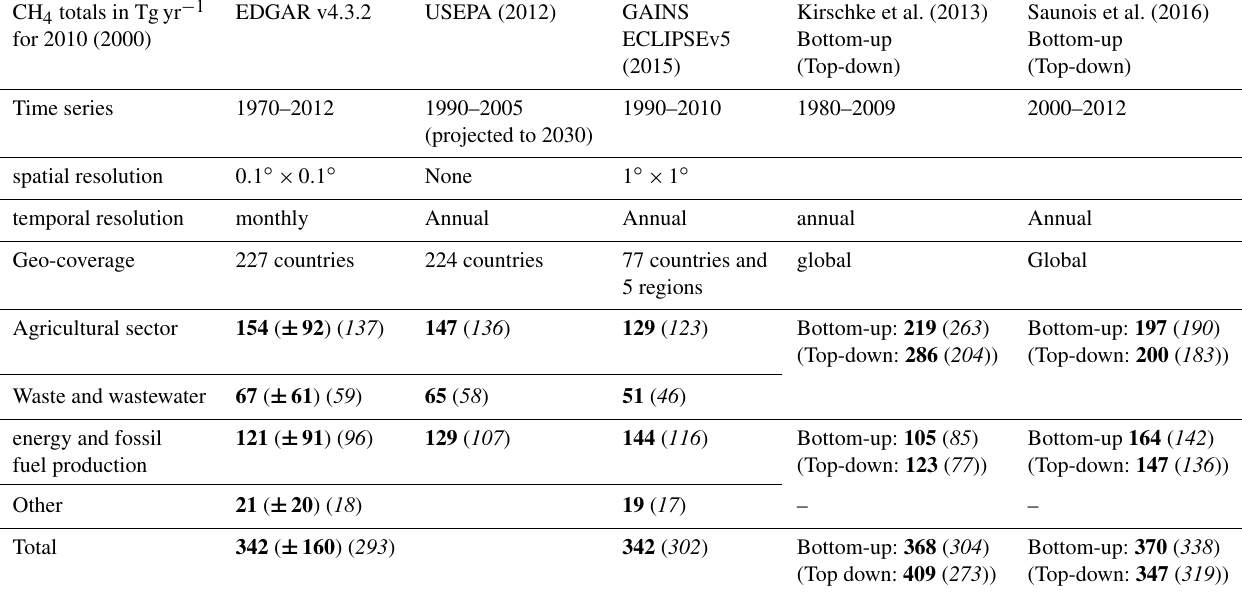
Table 4. Intercomparison of the global total PgCH 4 in 2010 by EDGAR v4.3.2 and by four other global emission inventories: USEPA (2012), GAINS-ECLIPSEv5 CH 4 of Höglund-Isaksson et al. (2015), Kirschke et al. (2013) and the global methane budget of Saunois et al. (2016). Note that the sector-specific global total is given in TgCH 4 yr − 1 for 2010 and in brackets for 2000. The USEPA 2010 value is projected. For Kirschke et al. (2013), instead of 2010 (2000) we used the maximum (minimum) of the 2000–2009 range. For Saunois we used instead of 2010 (2000) the 2012 value (mean value of the 2000–2009 range). The 2010 values are bold, and the 2000 values are in italics.